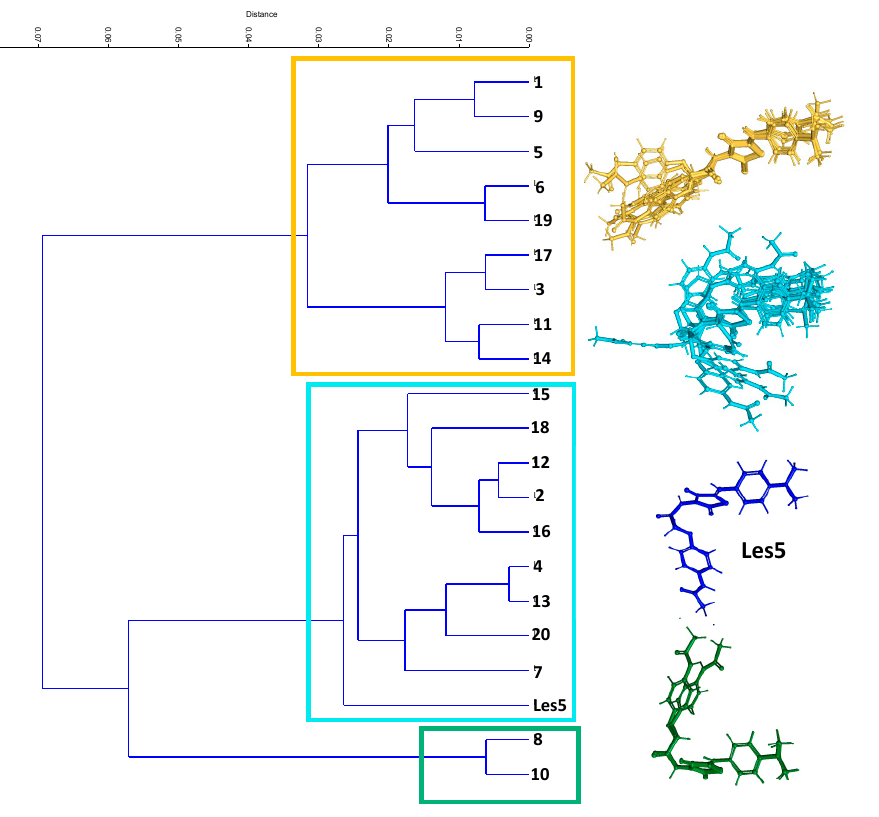
Figure 15. Results of cluster analysis based on atomic pairs contribution to the HATS5m value. The numbers denote the conformers of Les-5 molecule.